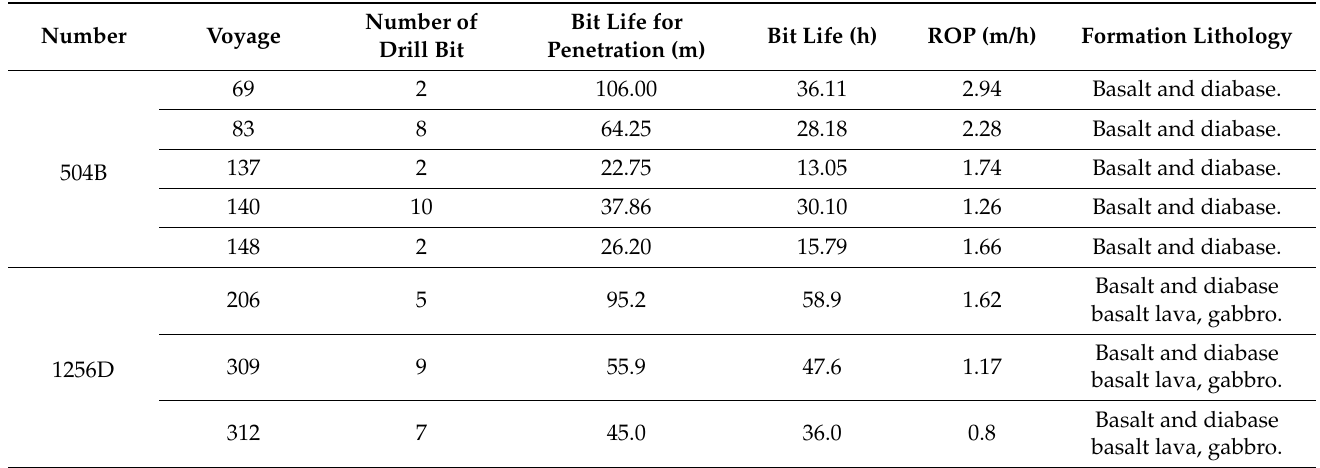
Table 2. The ROP and bit life of several hard rock deep holes in international ocean drilling (data were from preliminary report for each DSDP, ODP and IODP